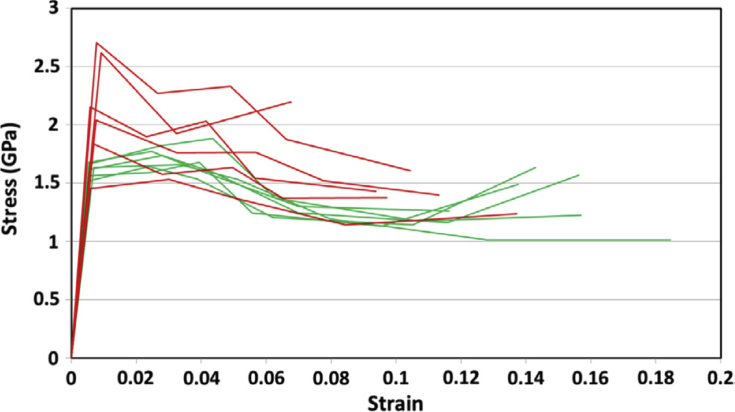
Stress-strain curves for ion-irradiated micro-cantilevers (red) and unirradiated micro-cantilevers (green). From Armstrong et al. [2015].45